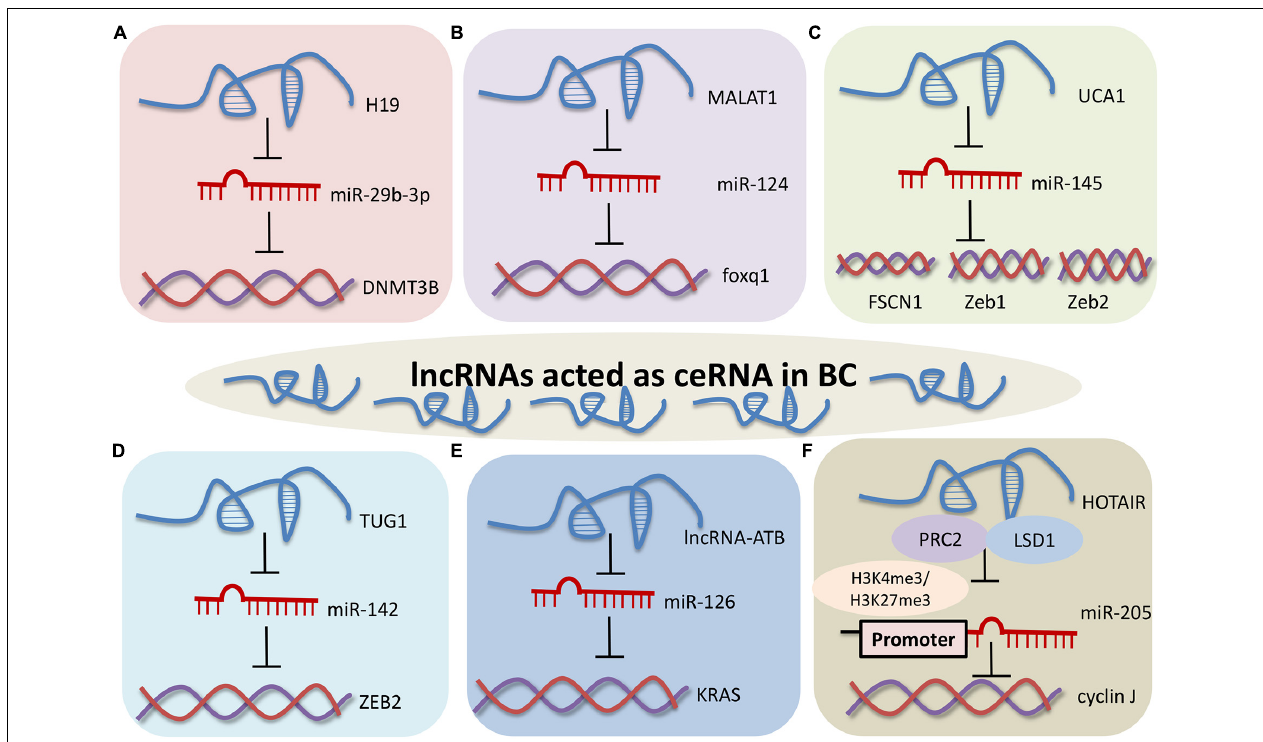
FIGURE 2 | LncRNAs exert their biological effects by sponging miRNAs in BC. (A) H19 regulated EMT and metastasis of BC through the H19/miR-29b-3p/DNMT3B axis. (B) MALAT1 promoted development of BC through the MALAT1/miR-124/foxq1 signaling pathway. (C) UCA1 enhanced BC migration and invasion through the UCA1-miR-145/FSCN1/Zeb1/Zeb2 network. (D) TUG1 enhanced proliferation of BC through the TUG1/miR-142/ZEB2 axis. (E) LncRNA-ATB positively regulated BC through the lncRNA-ATB-miR-126/KRAS. (F) The HOTAIR/miR-205/cyclin J signaling pathway in